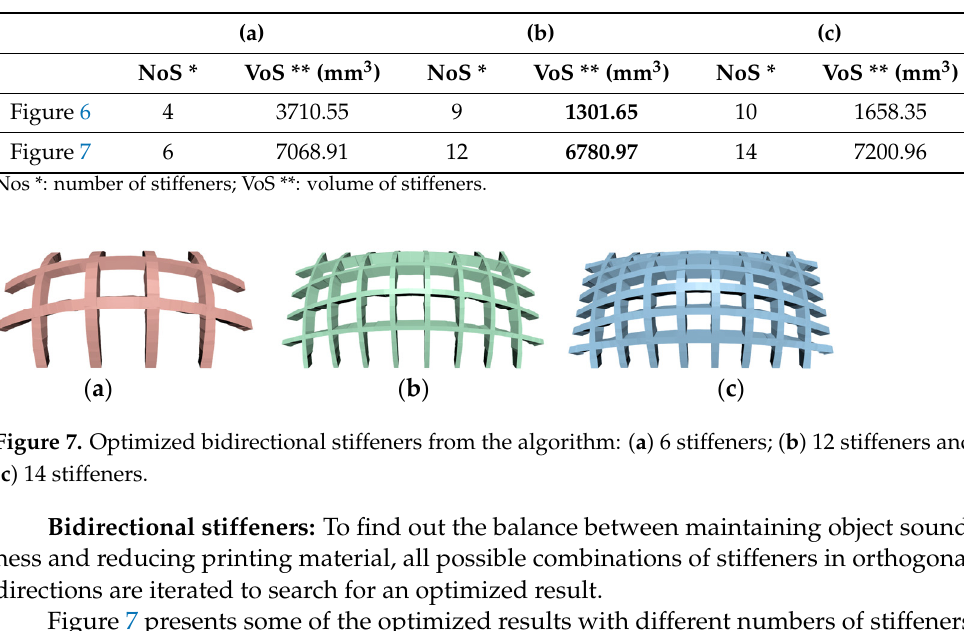
Figure 6. Optimized unidirectional stiffeners from the algorithm: ( a ) 4 stiffeners; ( b ) 9 stiffeners; ( c ) 10 stiffeners. Table 2. Stiffener number and volume.